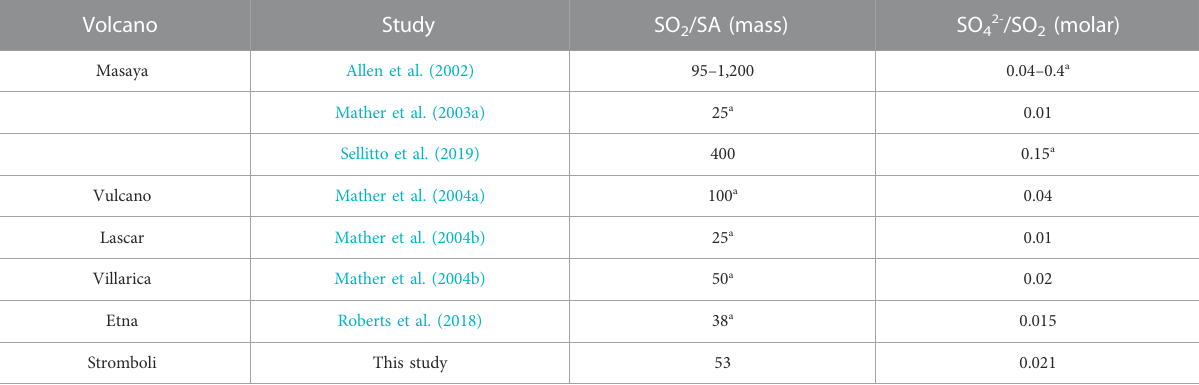
TABLE 4 Sulphur speciation in proximal volcanic plumes from this and previous studies. Volcano